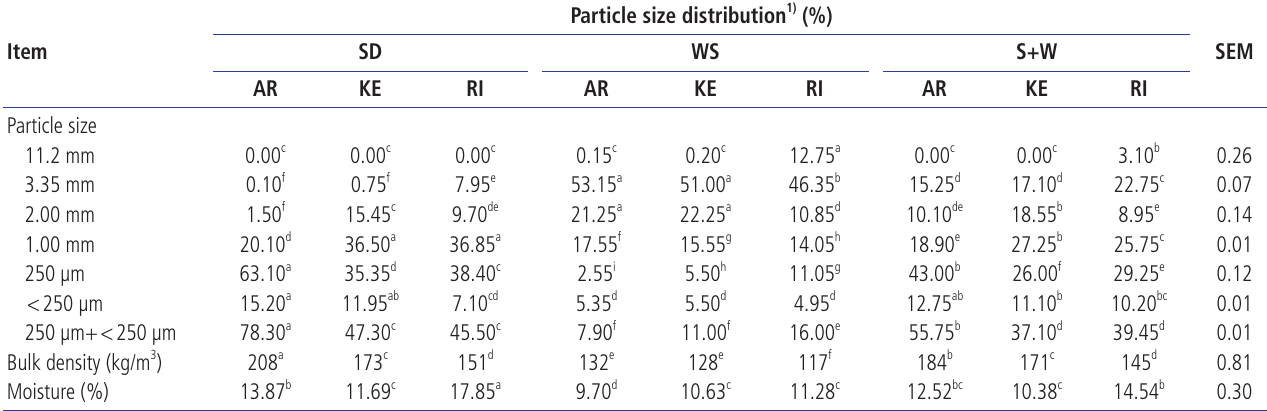
Table 2. Particle size distribution, bulk density and moisture concentration of bedding materials according to the species of pine trees